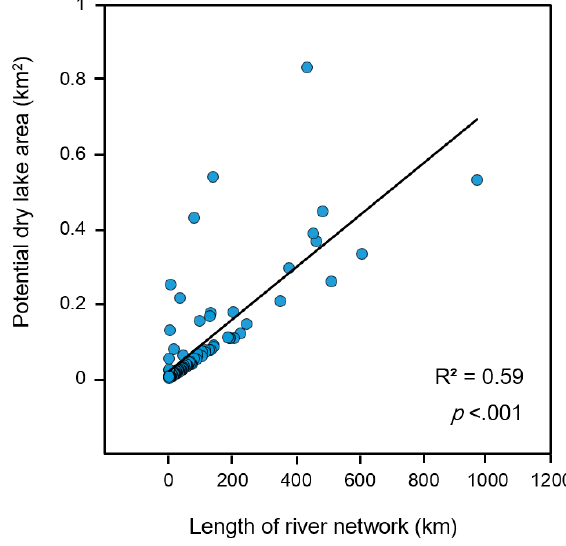
Figure 5. The distribution of potential dry lake beds and the river network.